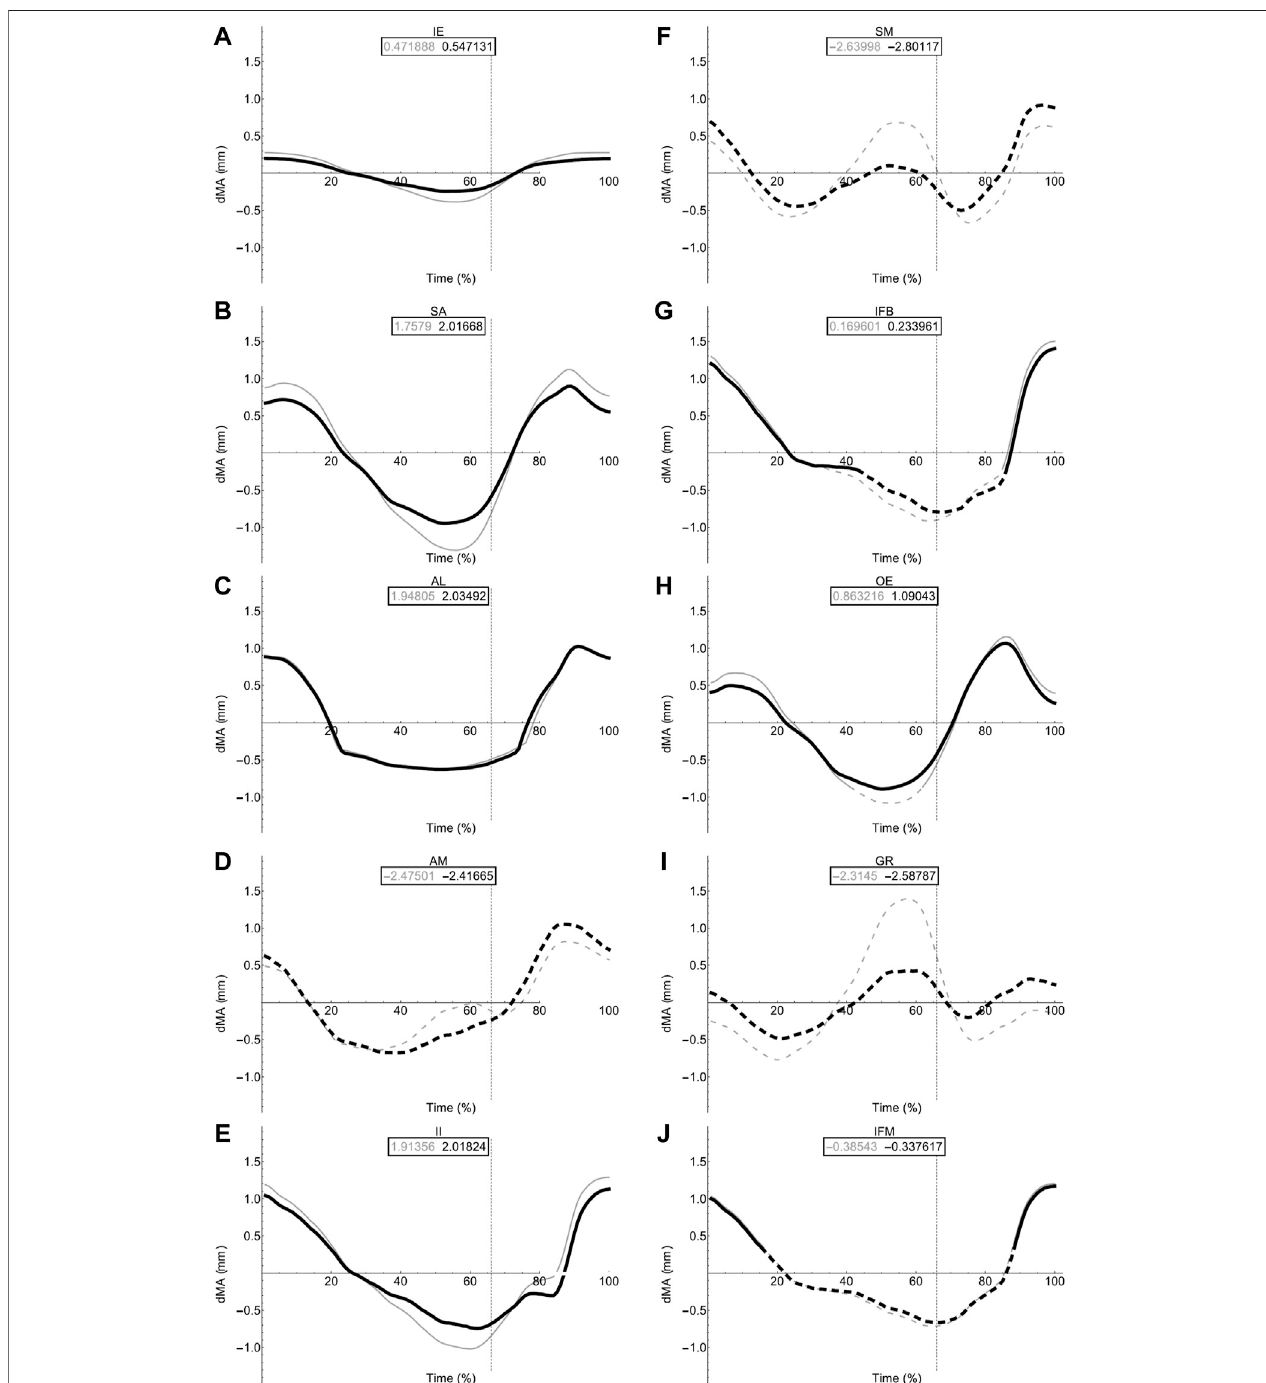
FIGURE8| Femoralmusclemomentarmsduringwalking.Changesinmomentarm(dMA)versustimeareshownforprotractormuscles (A – E) ;Iliacusexternus,IE, (A) , sartorius, SA (B) , adductor longus, AL, (C) , adductor magnus, AM, (D) , Iliacus internus, II (E) and retractors (F – J) ; semimembranosus, SM (F) , ilio fi bularis, IFB (G) , obturator externus, OE (H) , gracilis minor and major, GR (I) , iliofemoralis, IFM (J) for simulations with a mobile pelvis (natural condition; black) versus a fi xed pelvis (simulated condition; grey). See Figure 7 caption for further details. Solid versus dashed lines represent positive moment arms ( fl exion — femur protraction) versus negative (extension — femur retraction) such that a change from solid to dashed indicates a change in muscle function.